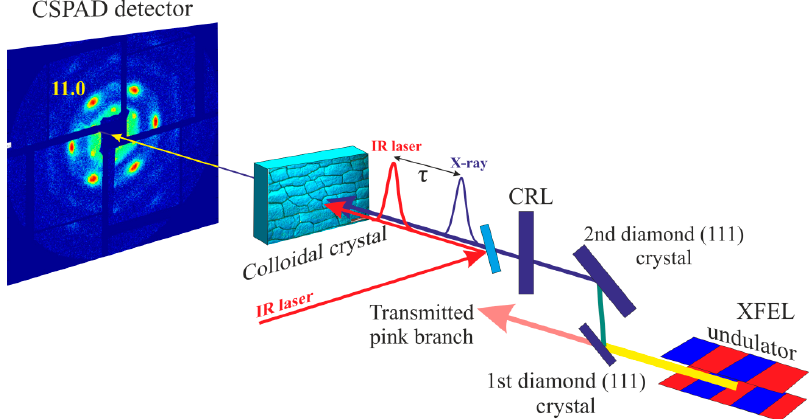
Figure 1 . The scheme of the pump-probe experiment. X-ray free-electron laser (XFEL) pulses are generated by the undulator and reflected by the first diamond crystal. The second diamond crystal reflects the beam in the direction to the sample position. The beam is focused by the compound refractive lenses (CRLs) to the size of 50 µm at the sample position. The Cornell-SLAC Pixel Array Detector (CSPAD) is positioned 10 m downstream from the colloidal sample.